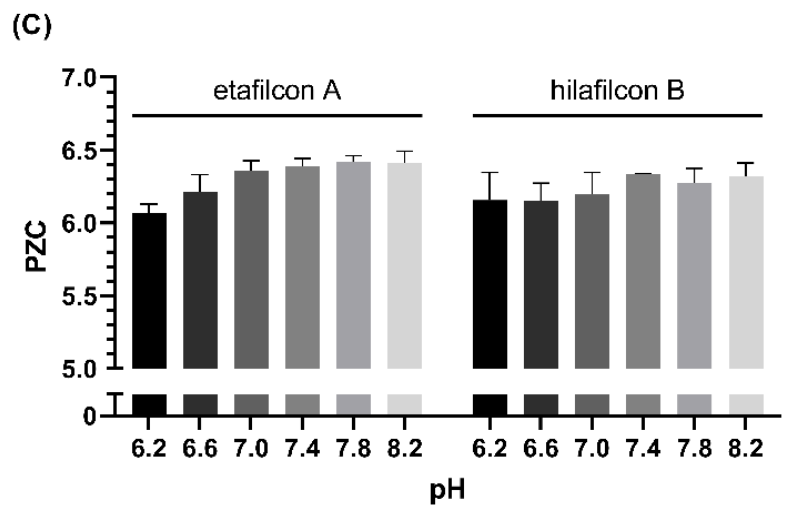
Figure 3. The ∆ pH of ( A ) etafilcon A and ( B ) hilafilcon B and ( C ) the PZC of etafilcon A and hilafilcon B equilibrated in PBS solutions (pH 6.2–8.2).